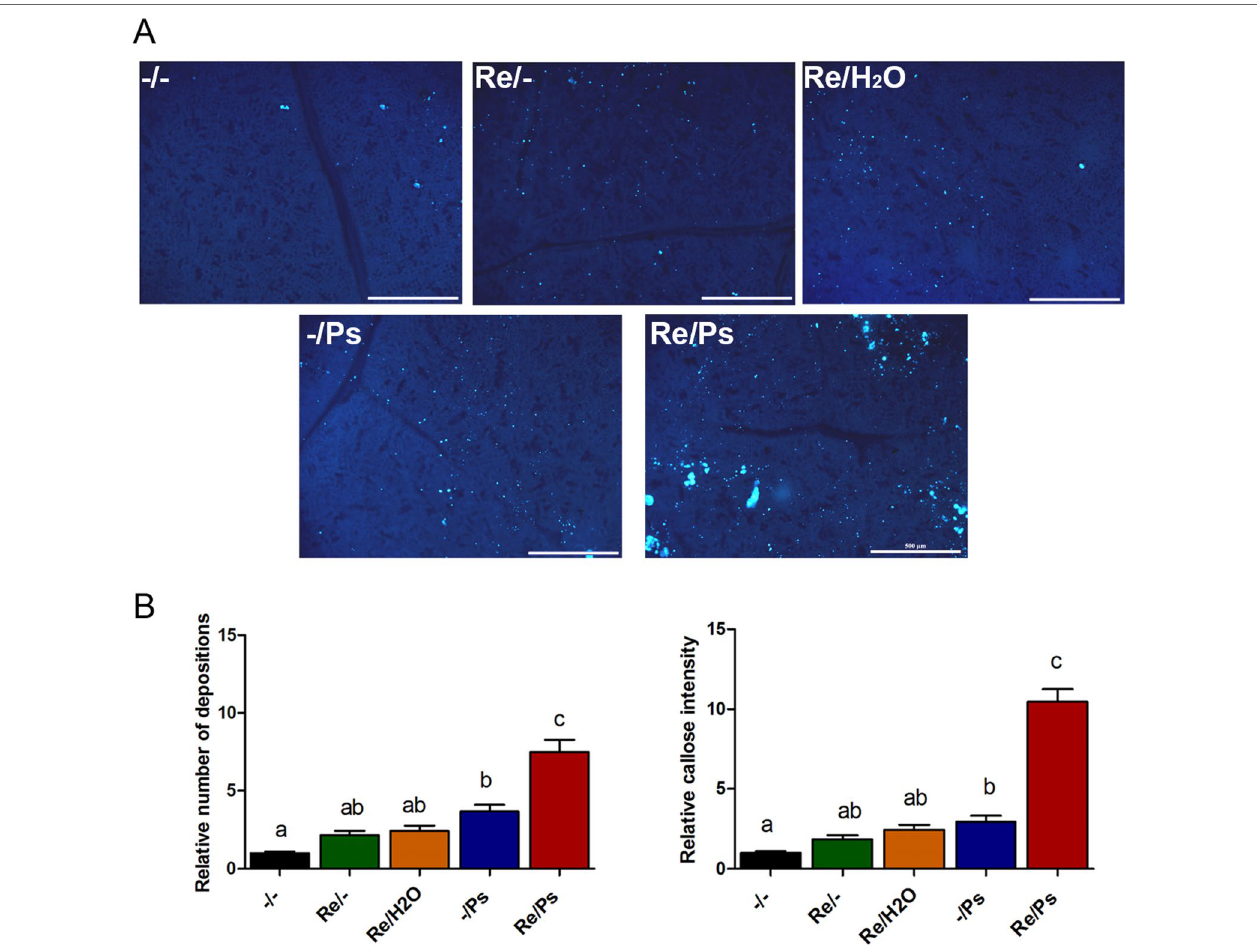
FIGURE 7 | Phenotype of R. etli-induced callose in F0 generation. (A) Morphological differences of callose depositions in 17 days-old P.vulgaris plants (co-cultivated with the symbiont), after PspNPS3121 infection. Representative photographs of aniline blue-stained leaves under UV epifluorescence illustrate differences in callose deposition between treatments. (B) Relative quantification of callose (number of individual depositions per unit of leaf surface) and callose intensity (number of fluorescent callose-corresponding pixels relative to the total number of pixels) were determined by using the Fiji software (according to Jin and Mackey, 2017). Values represent means (±SEM, n=24). Statistical significance was determined using one-way ANOVA followed by Tukey’s multiple comparison test, p < 0.05). Scale bar = 500 µm. Means with the same letter are not significantly